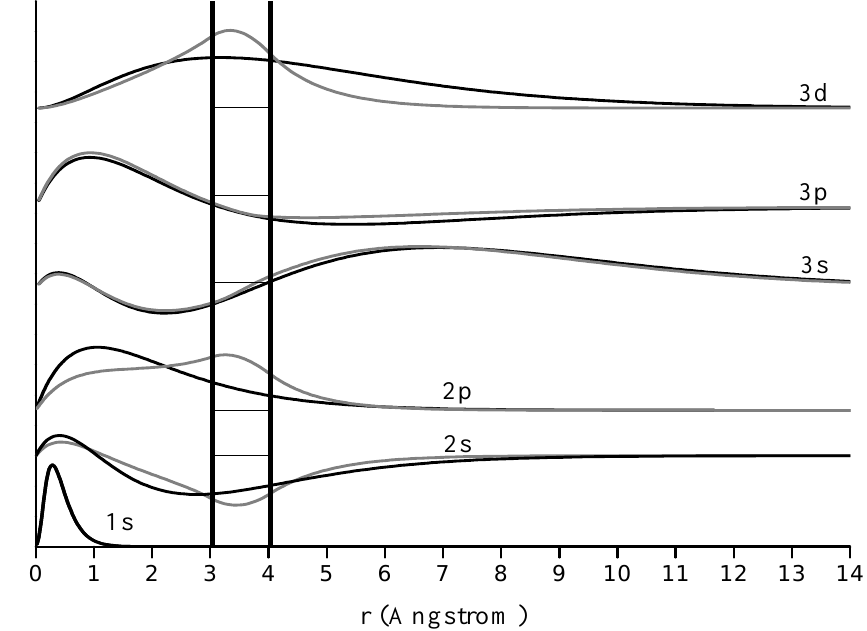
Figure 3. Radial wave functions rR of free and encapsulated hydrogen for n =1-3. Results for the former are in black and for the latter in gray. The horizontal axis is distance from the nucleus in Angstroms and the vertical axes are arbitrary but identical for both encapsulated and free species for a given quantum state. The boundaries of the jellium-shell are represented by vertical black lines. Various pairs of states are normalized and offset by different vertical amounts for visual clarity, and dashed horizontal lines within the jellium boundary indicate the respective wave function zeroes.